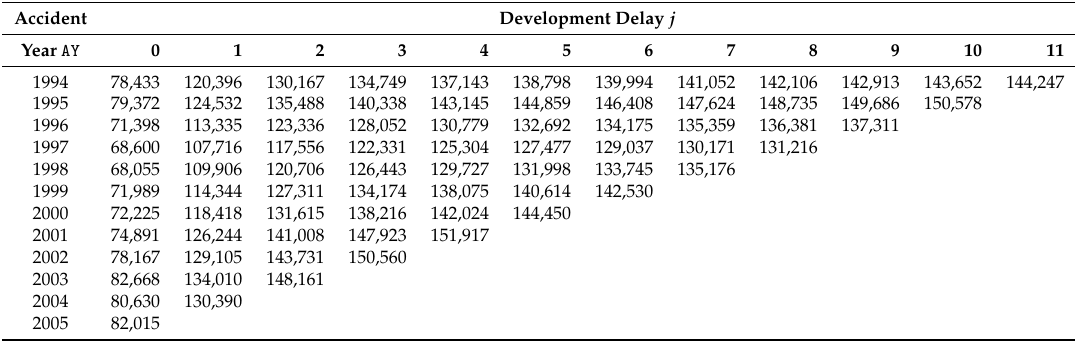
Table 4. Triangle of cumulative claims payments (in 10,000 CHF) of the real data.